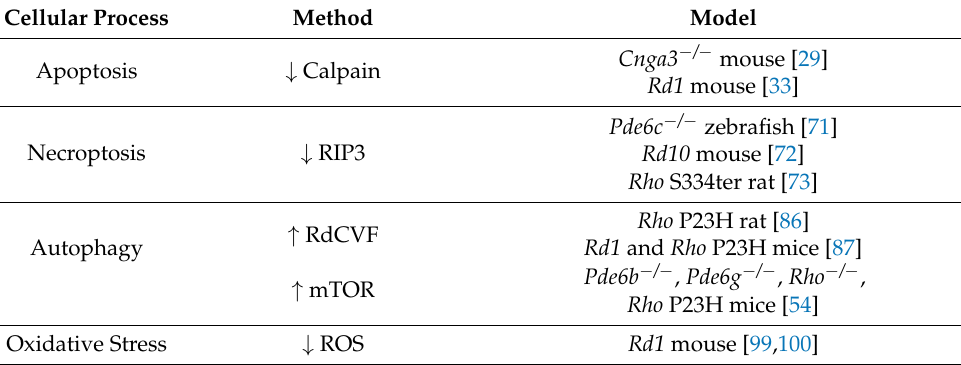
Table 1. Potential mutation-independent treatments for IRDs which showed preserved cone and/or rod survival in animal